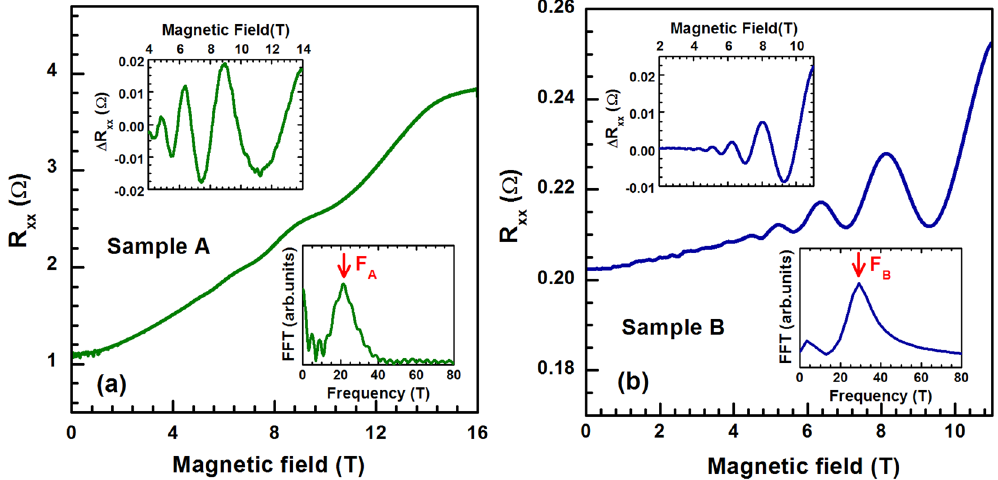
Figure 3. ( a , b ) Magneto-resistance data on samples A and B taken at the temperature of T = 4.2 and 1.4 K, respectively. The upper and lower insets show background-removed data Δ R xx and fast Fourier transform of − 1 ), respectively. The latter imply the oscillation frequencies F Δ R xx ( B the samples A and B,